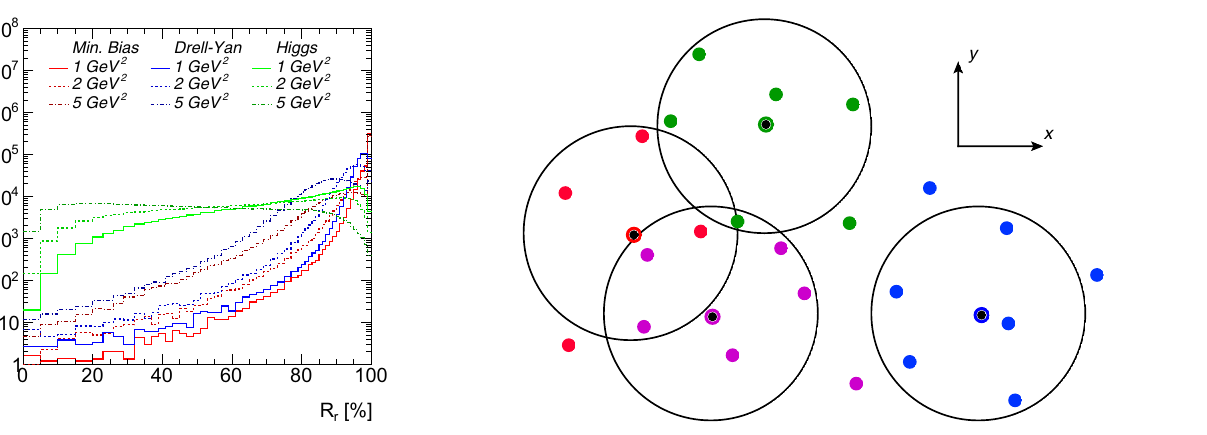
Fig. 5 The ratio of the distance traveled by partons in the last step of evolutiontothetotaldistance(distancetraveledduringentireevolution) variables correspondingly. All considerations below will be invariant to any boosts along the z -axis.